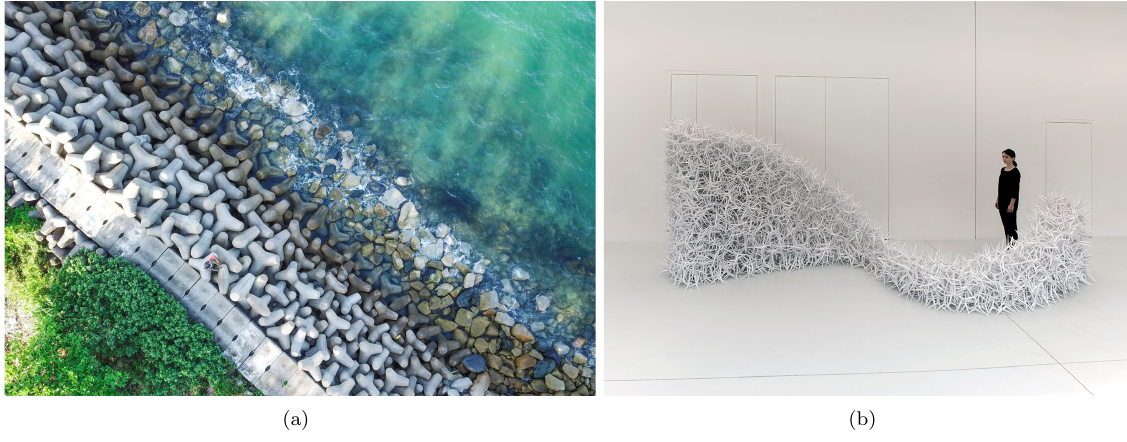
Figure 1: Examples of structures built using non-convex particles: a) coastal barrier (public image by Pok Rie [20]) and b) aggregate wall (with permission of Karola Dierichts